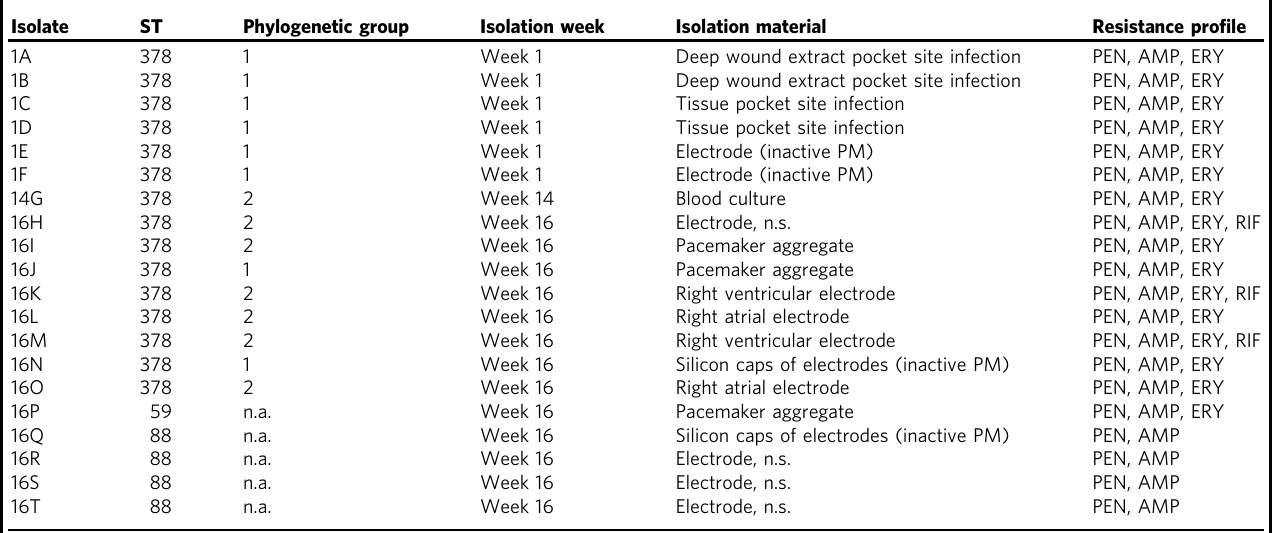
Table 1 List of S. epidermidis isolates obtained from the patient over the infection period